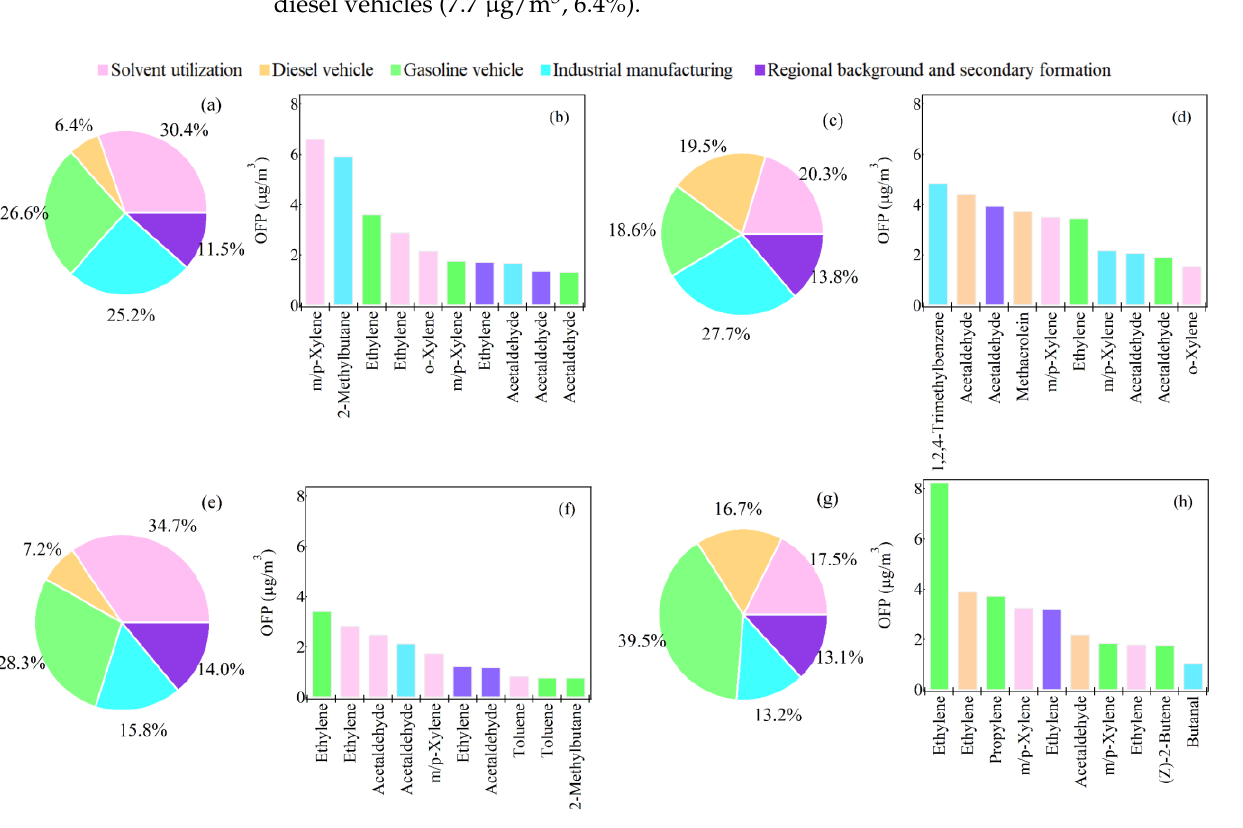
Figure 16. Contribution of different sources extracted from PMF to the total OFPs in ( a ) spring, ( c ) summer, ( e ) fall, ( g ) winter, and OFP values of the top ten VOCs from different sources in ( b ) spring, ( d ) summer, ( f ) fall, and ( h ) winter.